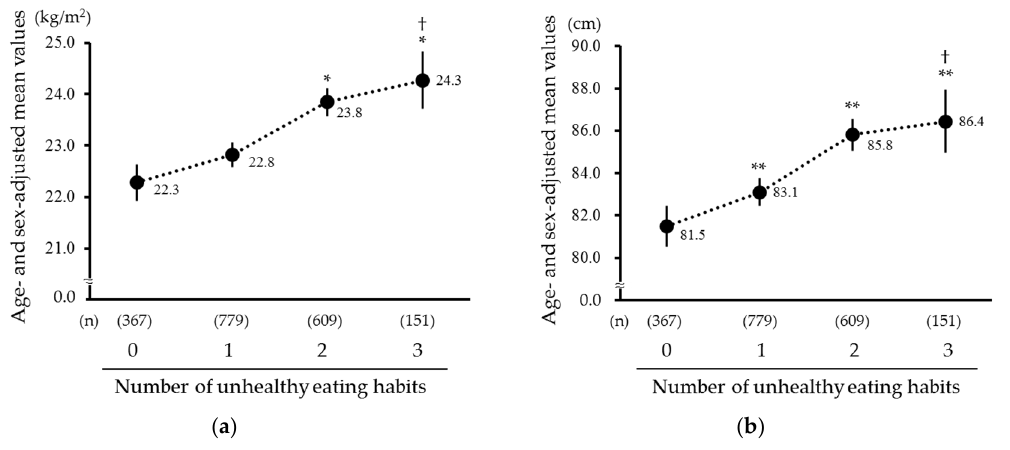
Figure 1. Age- and sex-adjusted mean values of body mass index and waist circumference according to the number of accumulated unhealthy eating habits: ( a ) Body mass index; ( b ) Waist circumference. Solid circles and vertical bars represent the mean values and 95% confidence intervals of each parameter, respectively. * p < 0.05, ** p < 0.01 vs. “0”, † p for trend < 0.001.